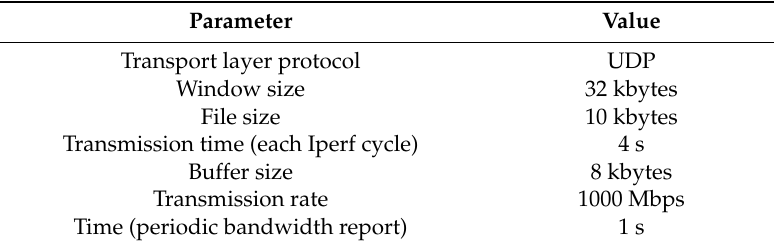
Table 5. Iperf simulation